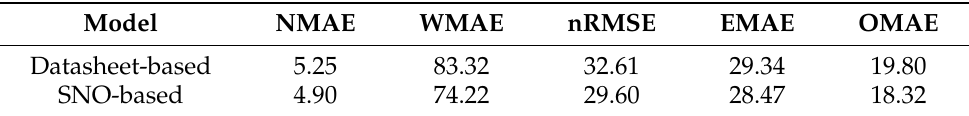
Table 3. Numerical comparison between the two models according to average error values. NMAE: normalized mean average error; nRMSE: normalized root mean square error; OMAE: objective mean average error.